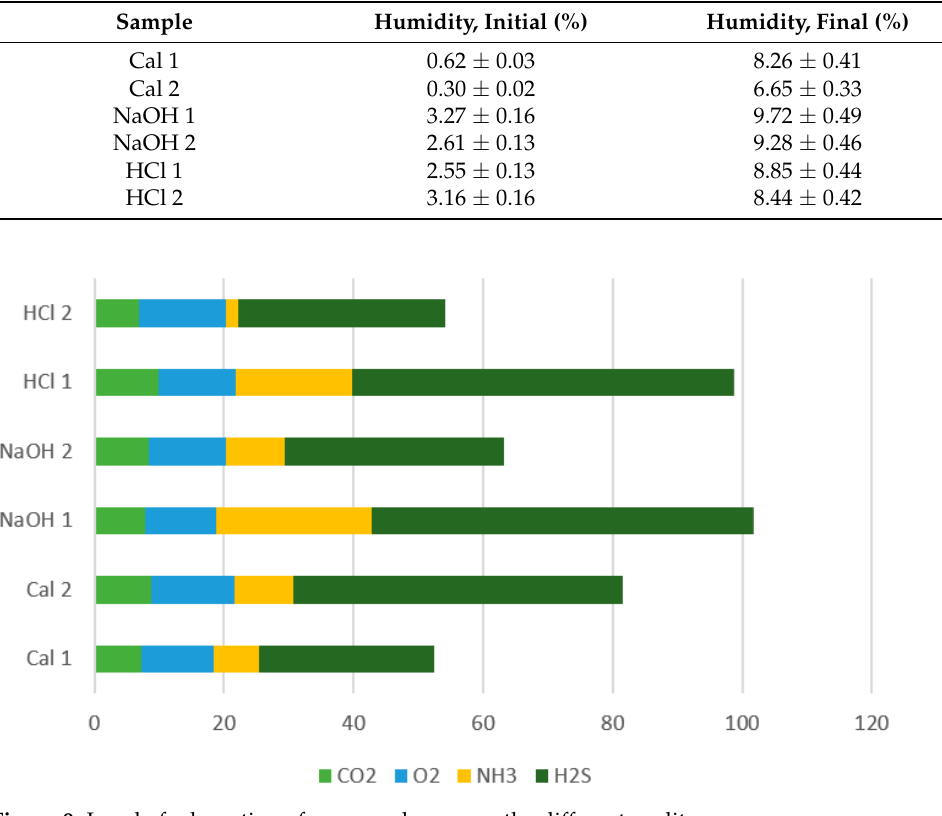
Figure 9. Level of adsorption of measured gases on the different zeolites. The grades obtained by each zeolitic material are presented in Table 7. Table 7. Grade obtained by each zeolite sample and the final grade base on Equation (1).